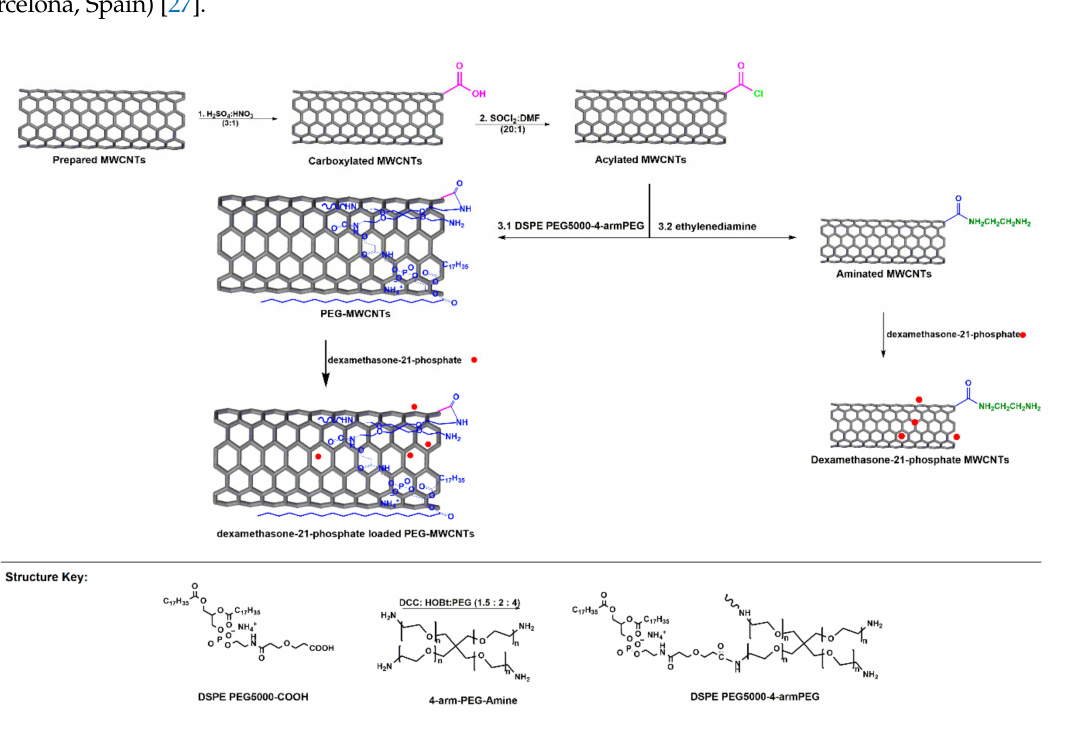
Scheme 1. Schematic illustration showing the preparation of